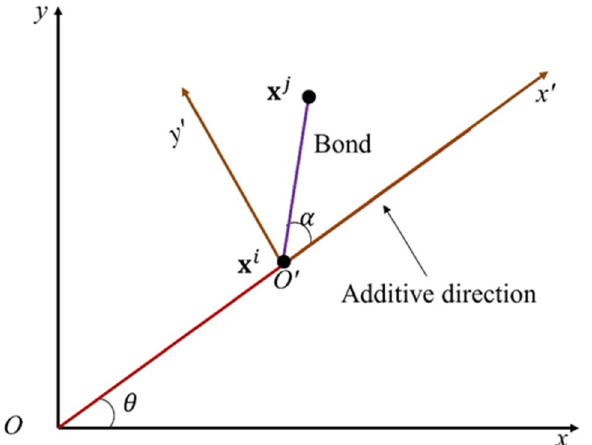
Figure 1. Schematic diagram of the local the global coordinate